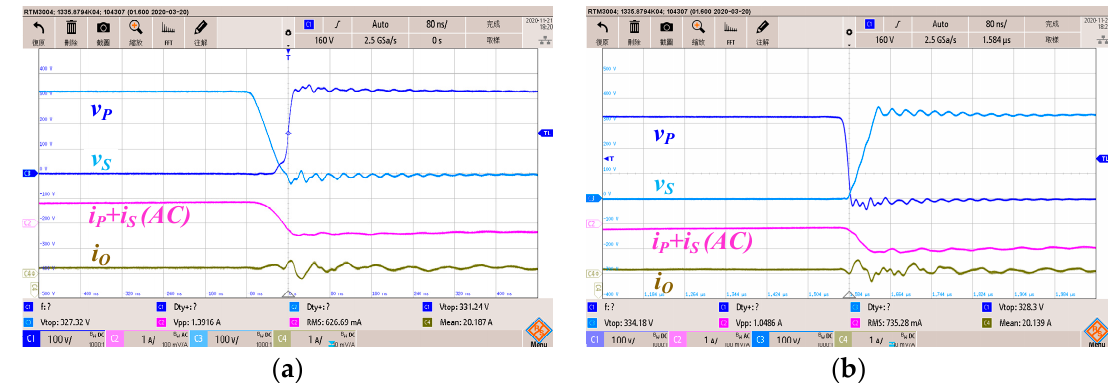
Figure 29. Measured waveforms of the switching node voltage, sum of inductor current ripple and output current using the conventional dead time: ( a ) dead time interval: t 1 ~t 2 ; ( b ) dead time interval: t 3 ~t 0 +T . [scale v P (Ch1): 200 V/div; i P + i S ( AC ) (Ch2): 5 A/div; v S (Ch3): 200V/div; i O (Ch4): 1A/div; time: 80